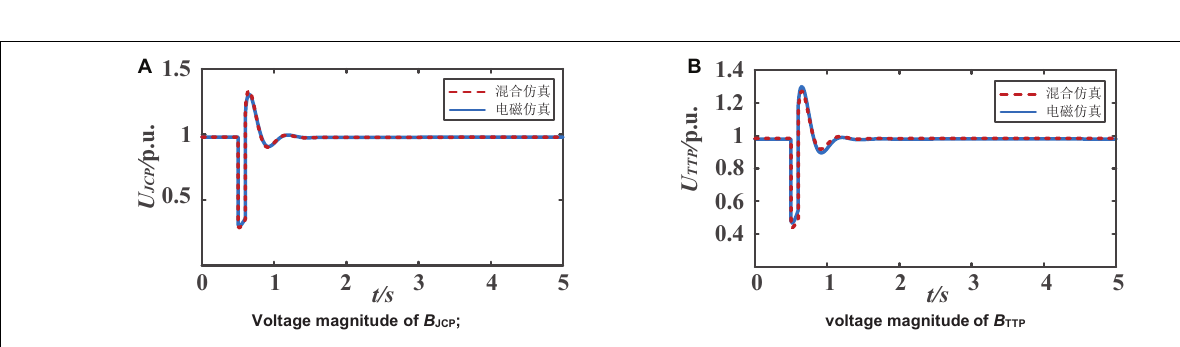
FIGURE 11 | Comparisons of voltage magnitude of interface buses; (A) Voltage magnitude of B JCP ; (B) Voltage magnitude of B TTP .